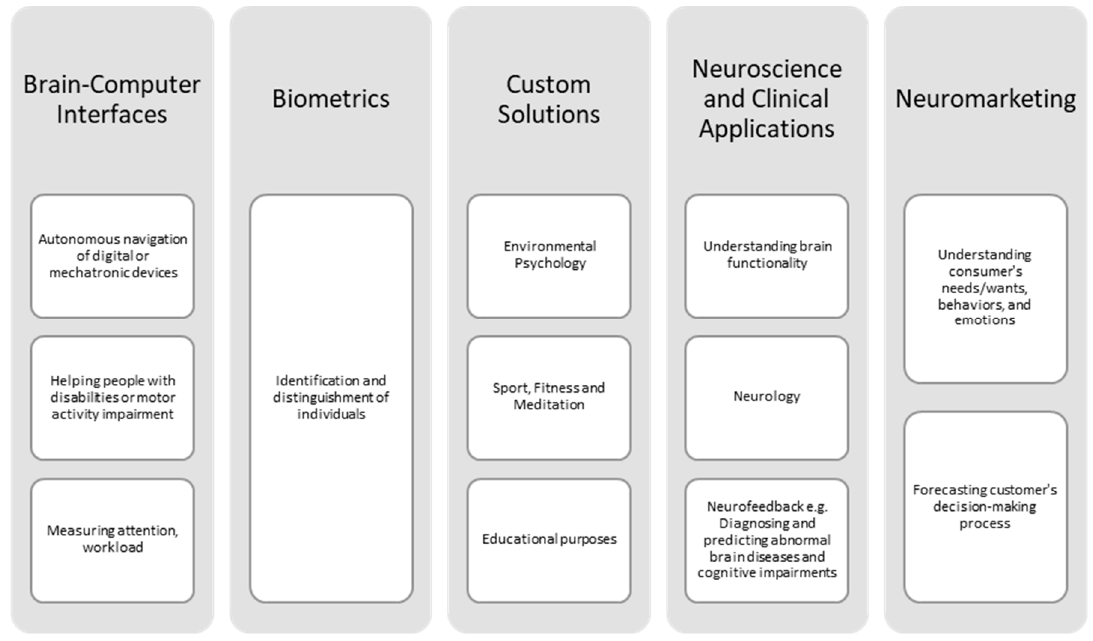
Figure 3. Electroencephalography (EEG) applications.